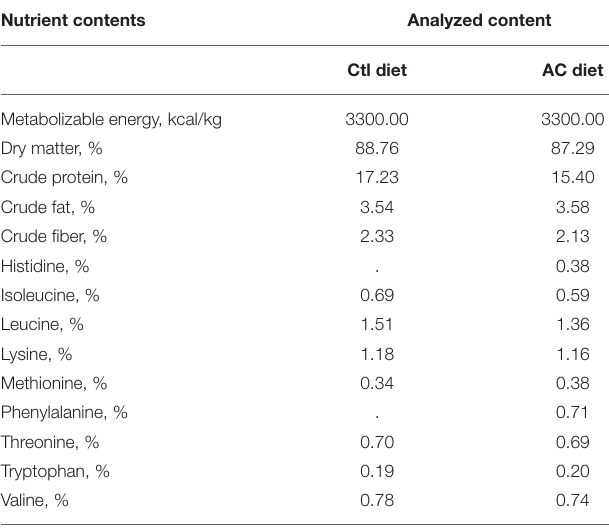
TABLE 1 | Diet composition 1 (% as is basis) of the control (Ctl) and adequate control (AC) pig diets in study #1 and study #2,